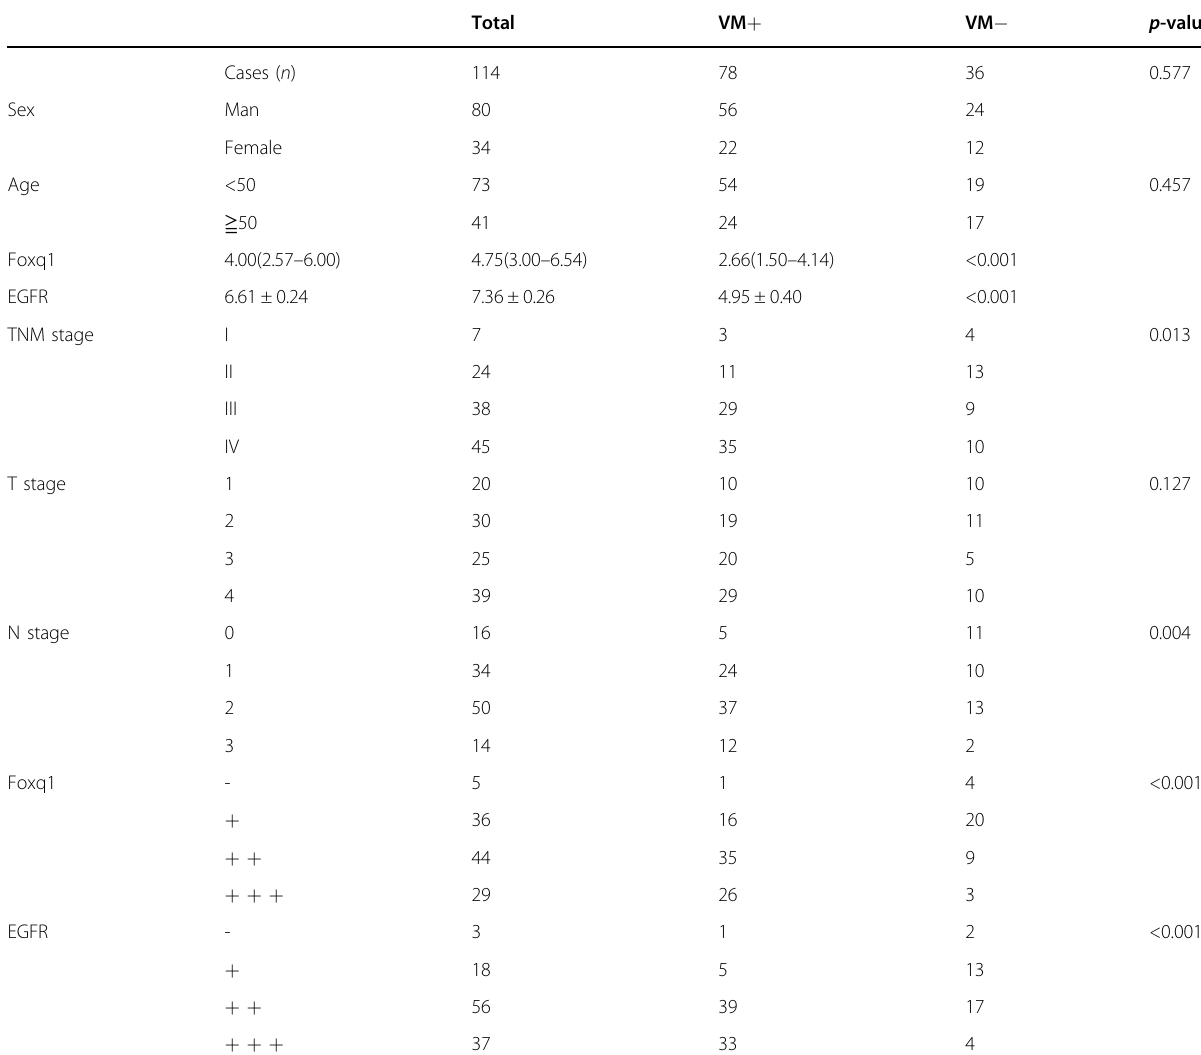
Table 1 The relationship between VM expression (VM + : CD31 – /PAS + ; VM-: CD31 + /PAS – ) and NPC clinicopathological